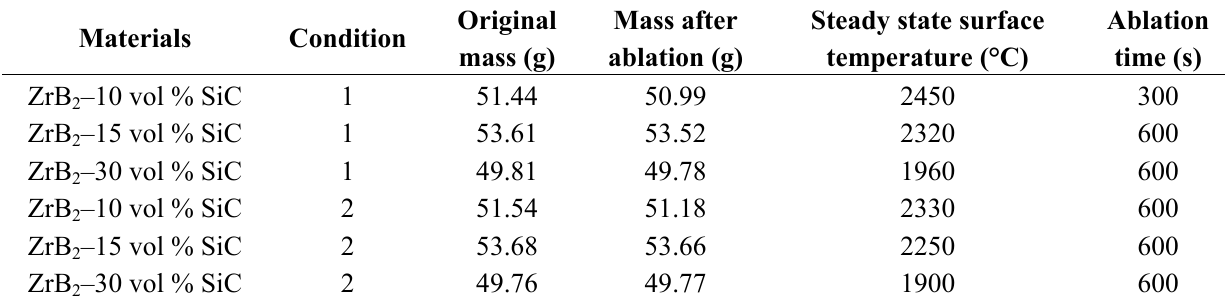
-based ultra high temperature ceramic composites. 2